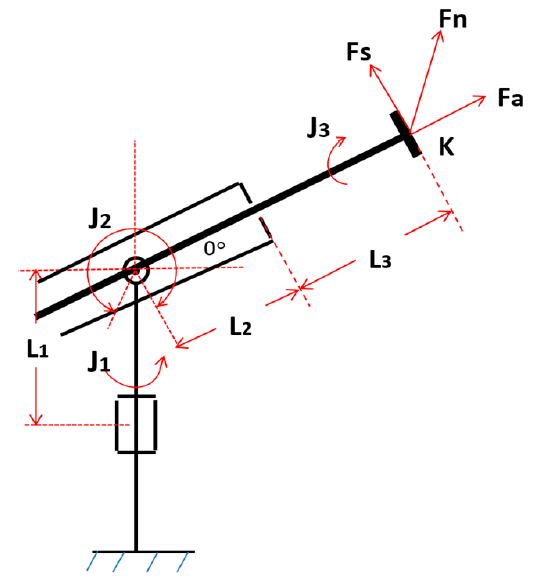
Figure 2. Kinematic chain of the 3-DOF force feedback system.